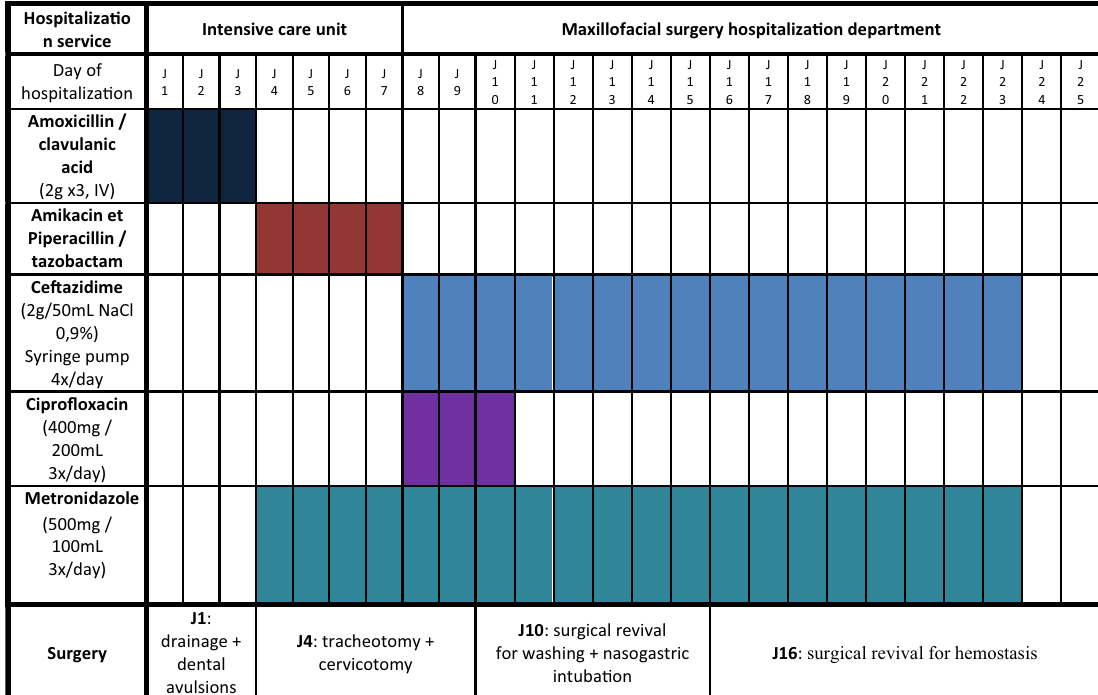
Table 1. Therapeutic chronology (surgical procédures, hospitalization, antibiotic therapy).